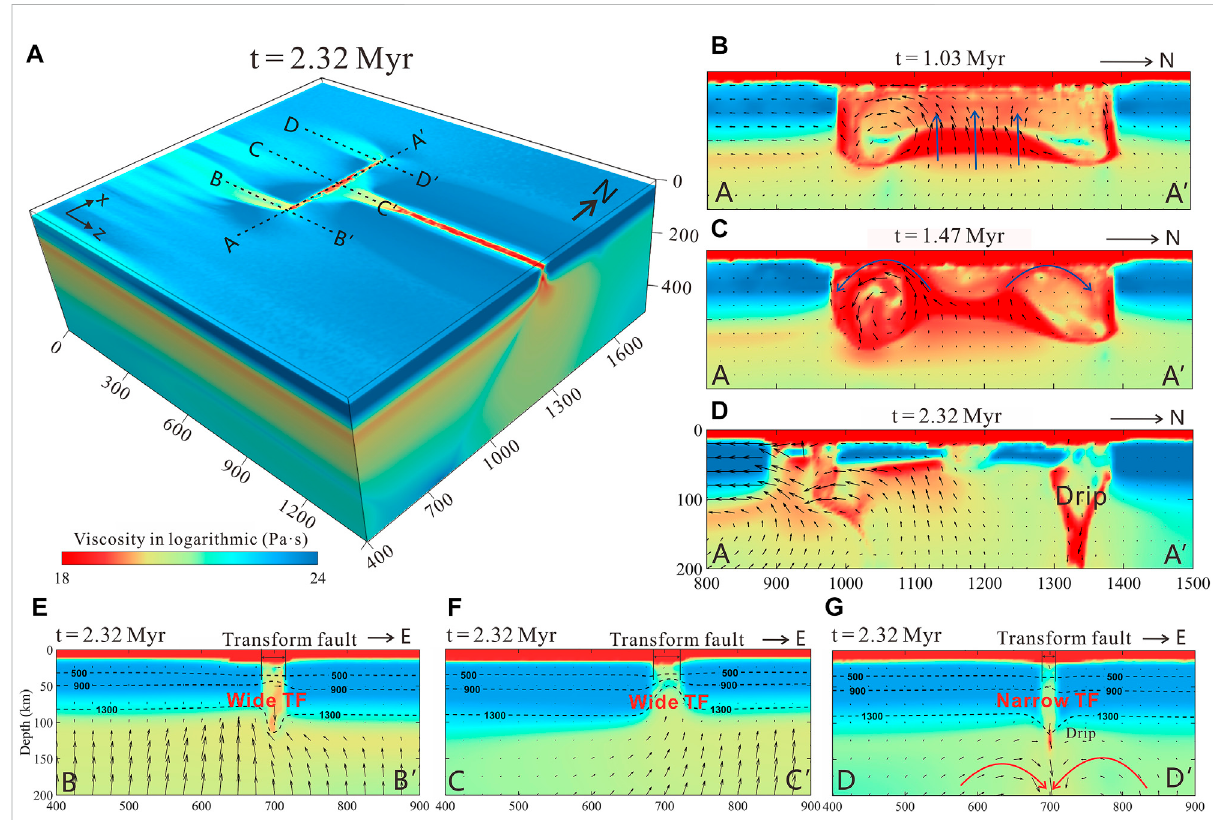
FIGURE 10 Transform fault evolution affected by rifting/spreading propagation. (A) Model results at 2.32 Myr shown by viscosity fi eld in 3D view. Black dashedlinesarecrosssectionsshownin (B – G) . (B – D) TemporalevolutionofAA ′ pro fi lealongthestrikeofthetransformfault(timesat1.03,1.47and 2.32 Myr) (E – G) Cross sections perpendicular to the transform fault. Black arrows represent velocity